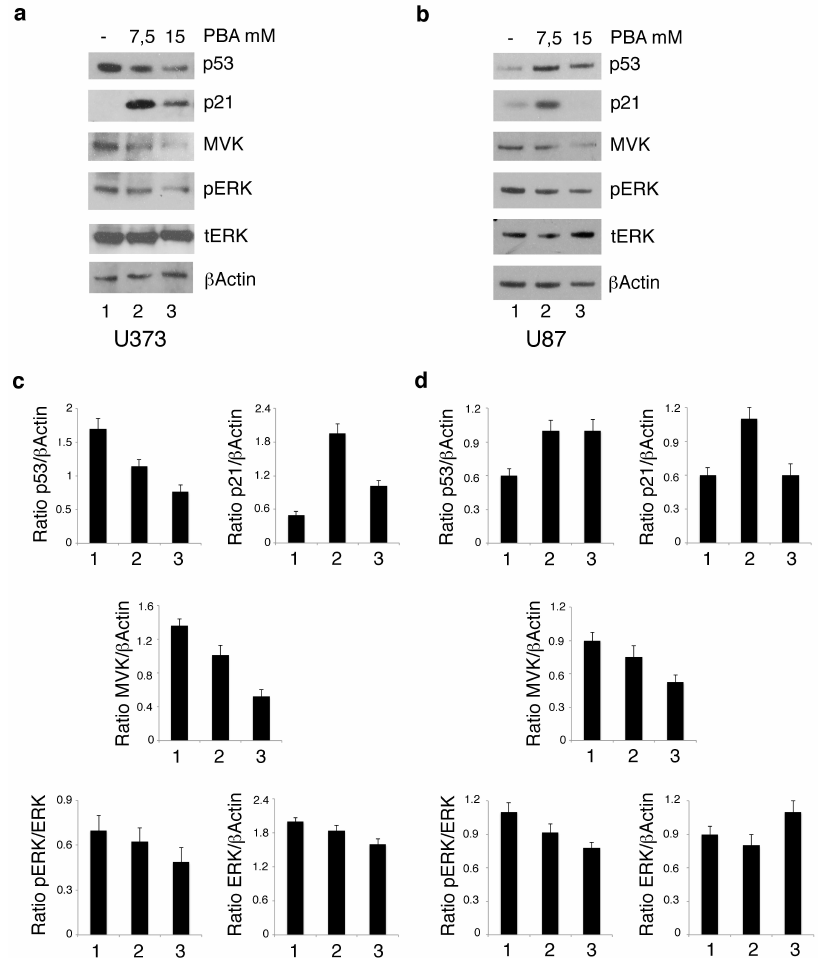
Figure 2. PBA reduces mutp53 expression in U373 cells and activates wt p53 in U373 and U87 cells, reducing the MVK of mevalonate pathway. U373 ( a ) and U87 ( b ) cell lines, cultured for 24 h in the absence and in the presence of 7.5 mM or 15 mM PBA, were analyzed by Western blot for p53, p21, MVK, pERK and ERK protein expression. β Actin was used as loading control. One representative experiment out of 3 is shown. In c and d , the histograms represent the mean plus SD of the densitometric analysis of the ratio of p53, p21, MVK, pERK and ERK on the loading control of 3 di ff erent